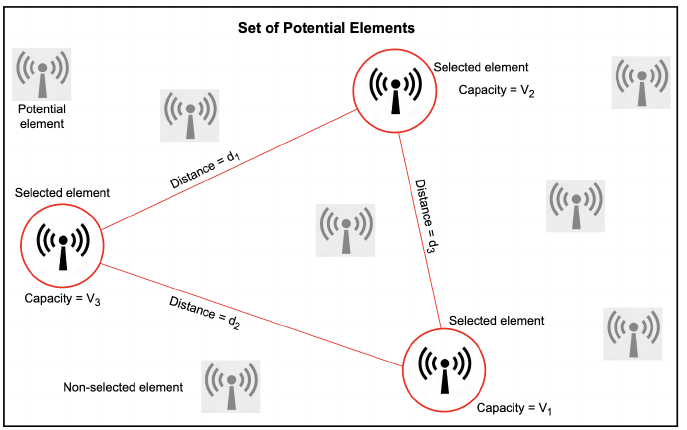
Figure 1. Simple example of a CDP